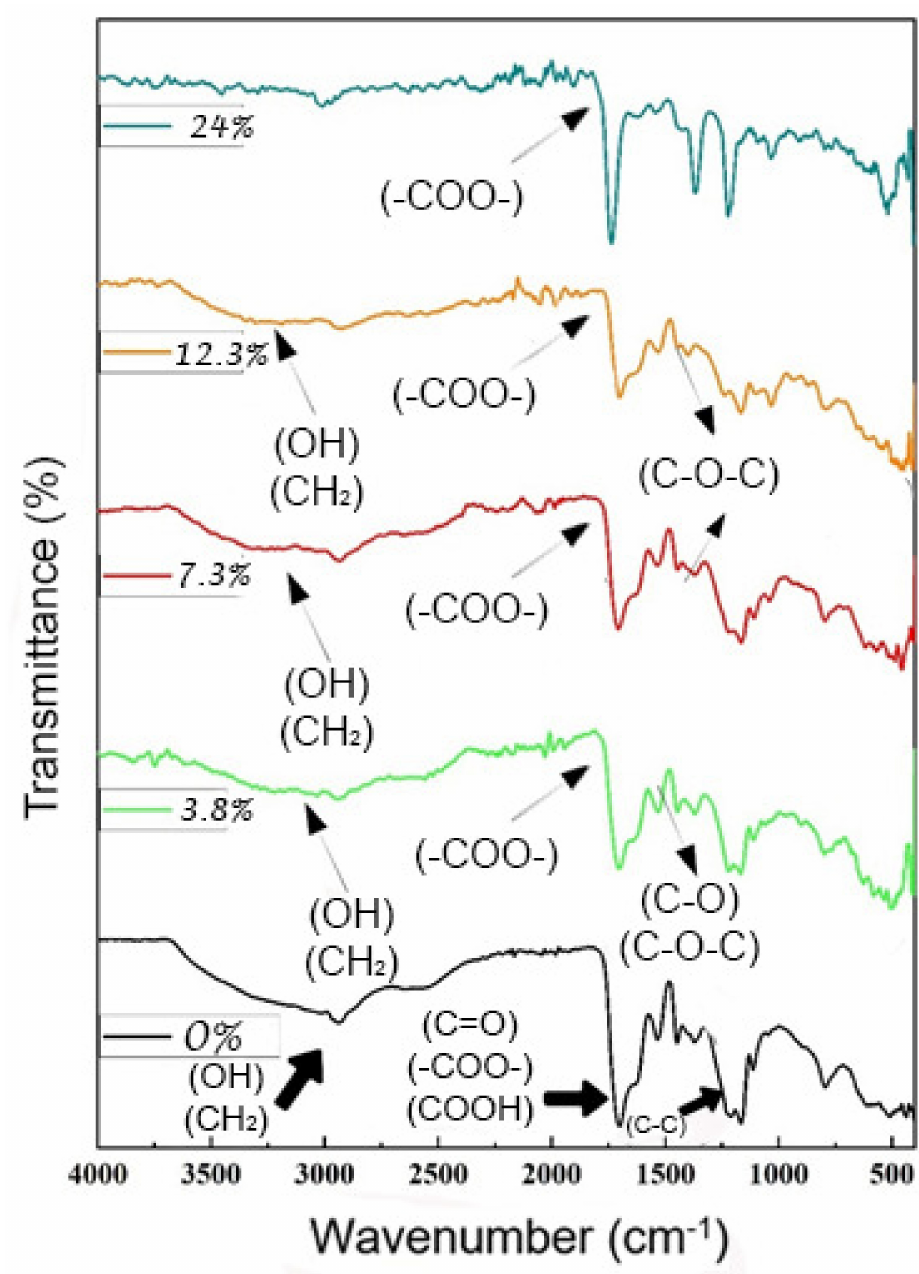
Figure 5. FT-IR spectra of PAA/alginate xerogels containing different amounts of